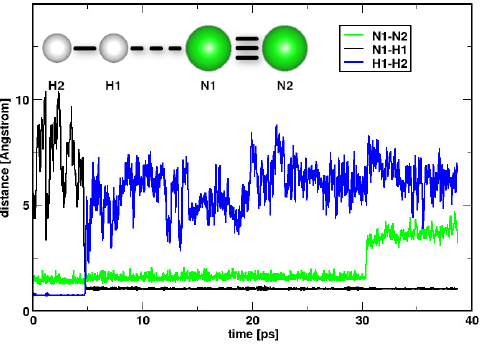
Figure 5. Simulation 10 , second reaction: in the beginning, N-H is formed. Almost simultaneously, the H-H bond breaks. A few picoseconds later, the N-N bond is